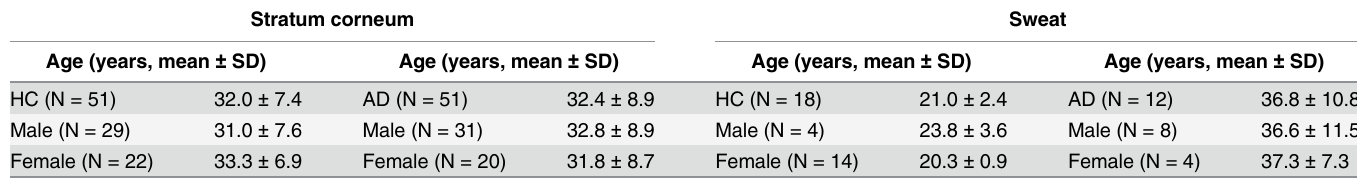
Table 1. Collection of stratum corneum samples and sweat samples from healthy controls and atopic dermatitis